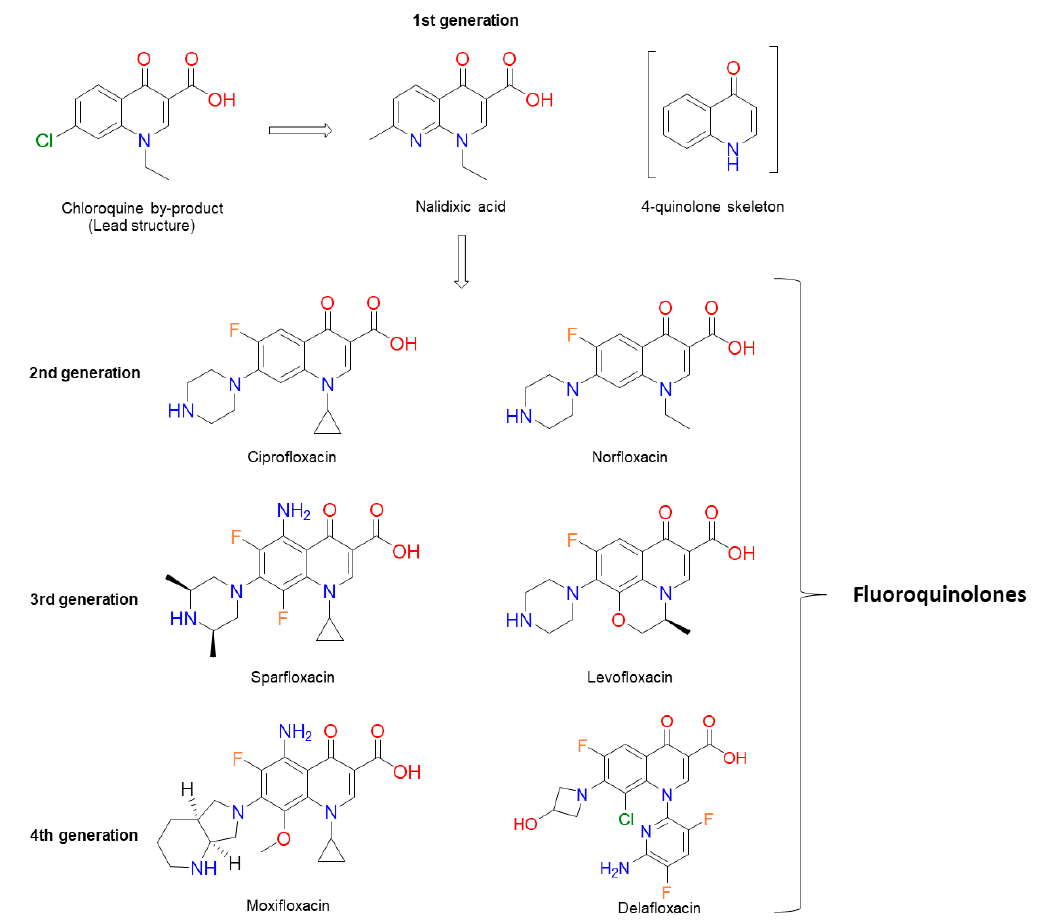
Figure 1. Chemical structures of several significant fluoroquinolones. Nalidixic acid (the first “quinolone”) is shown, along with the chloroquine by-product inspiring its synthesis. Note that nalidixic acid lacks the 4-quinolone core and instead contains a 1,8-naphthyridine